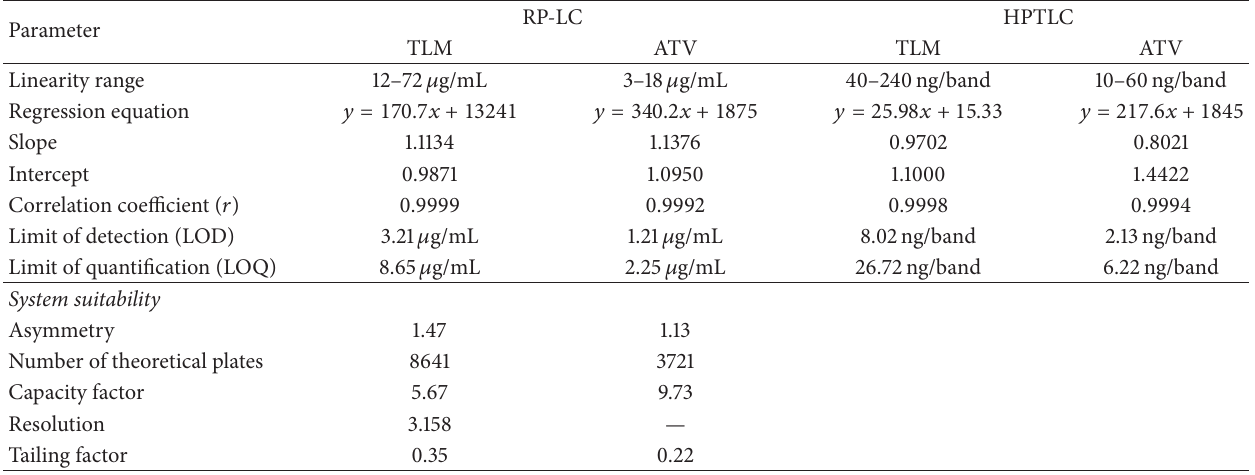
Table 1: Data for calibration graphs and system suitability ( 𝑛 = 3 ).